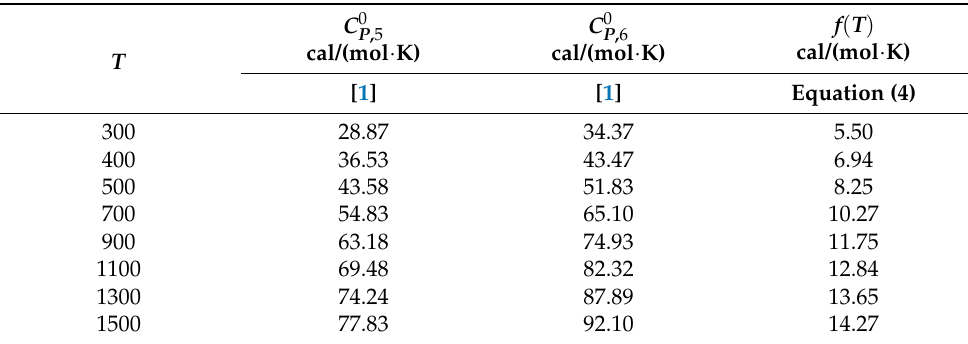
Table 2. Accuracy of Equation (5) for C 0